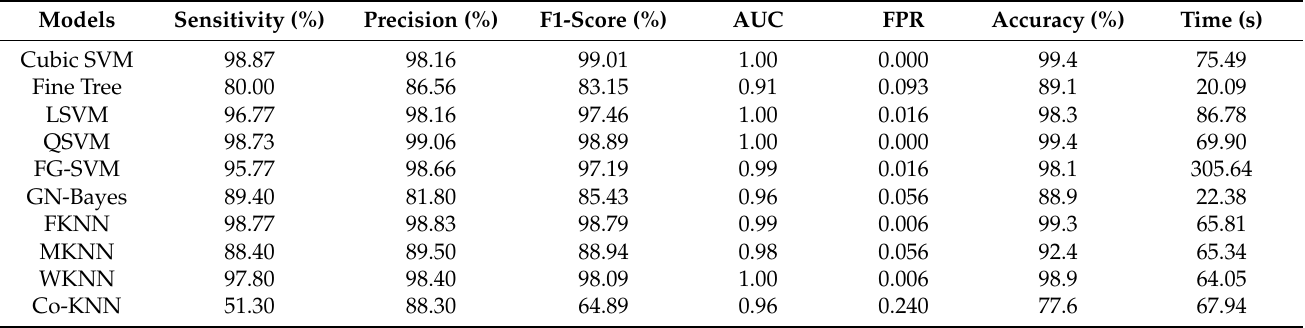
In Table 10, MEWOA on Fine-tuned MobilenetV2 model is applied to the MIAS dataset. The GAP layer is used to extract the deep features and fed to classifiers. Table 10. Classification results using MEWOA on Fine-tuned MobilenetV2 deep features for MIAS.